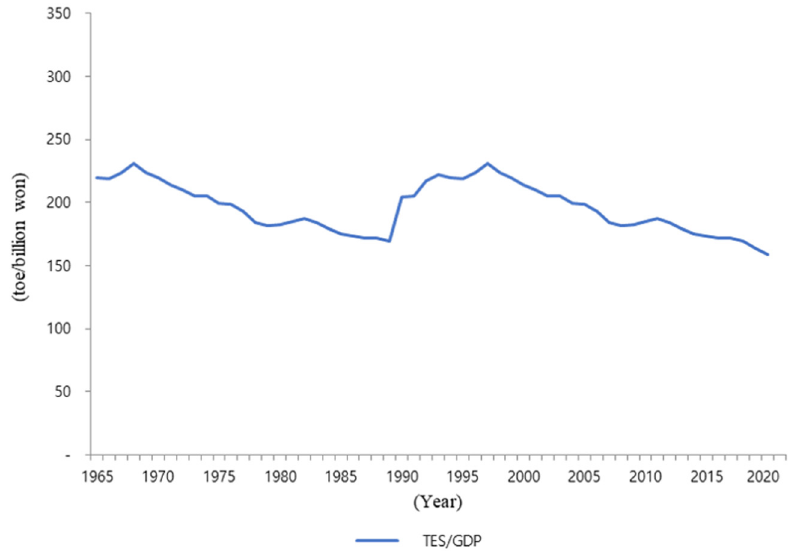
Figure 5. Energy consumption per GDP [45,46].